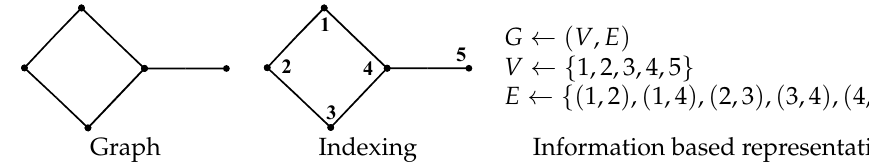
Figure 1. A simple connected undirected unweighted